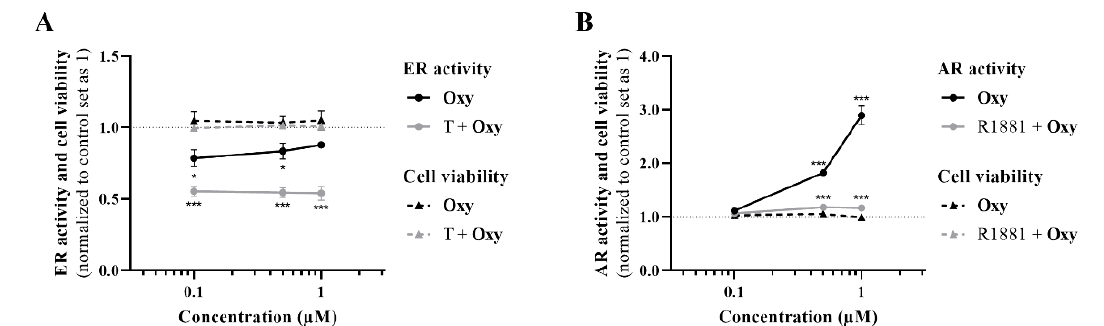
Figure 6. ER and AR transactivation assays. ( A ) Effects of Oxy (0.1–1 μ M) on ER activation, in the presence or absence of 1 nM T, after 24 h of incubation. ( B ) Effects of Oxy (0.1–1 μ M) on AR activa ‐ tion, in the presence or absence of 0.1 nM R1881, after 24 h of incubation. Data were normalized to control (cells not treated with Oxy ), which was set as 1. Results are presented as mean ± SEM of four independent experiments, each performed in triplicate. Significant differences between the control and cells treated with Oxy are denoted by * ( p < 0.05) and *** ( p < 0.001).